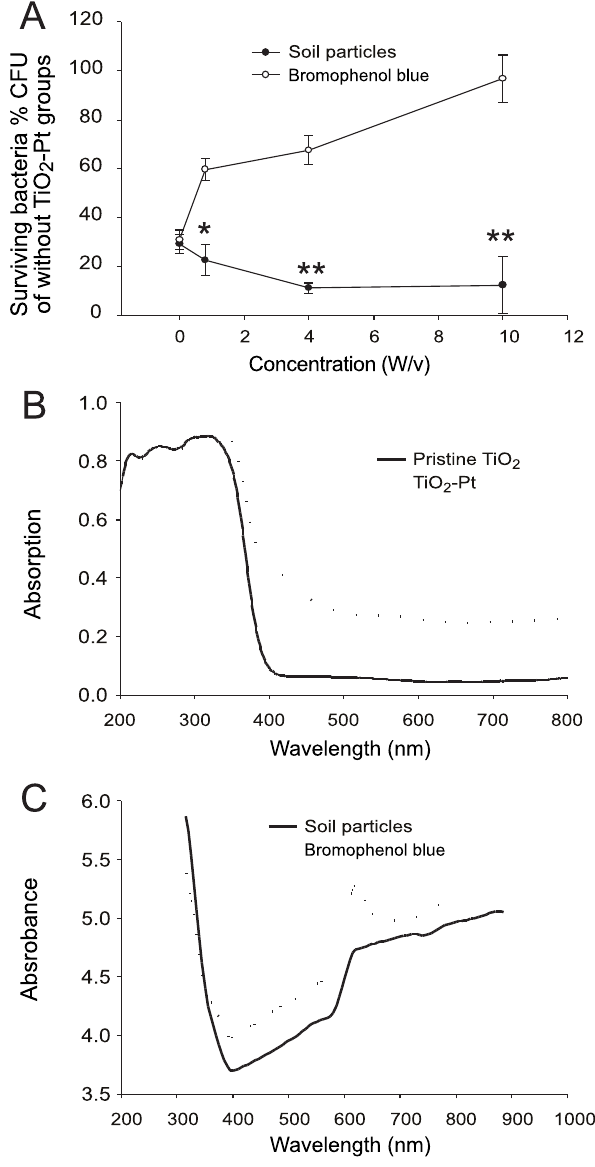
Figure 7. The antibacterial activity of the TiO 2 -Pt photocatalyst in soil-containing solutions. The survival rates of B. cenocepacia cells (strains P2) in different concentrations of soil particle and bromophenol blue solutions are shown (A). The data are presented as mean 6 SD. * P , 0.05 and ** P , 0.01, compared with the respective bromophenol blue groups. The UV-visible light absorption spectra of TiO 2 -Pt and pristine TiO 2 are shown (B). The absorbance of 10% w/v soil- and bromophenol blue-containing solutions at various wavelengths is indicated (C). n=6, three experiments with 2 replicates.